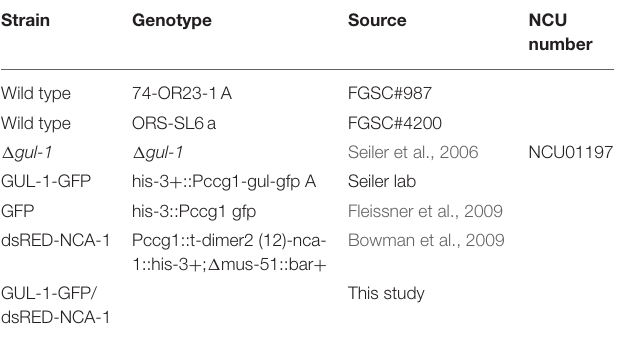
TABLE 1 | Neurospora crassa strains used.